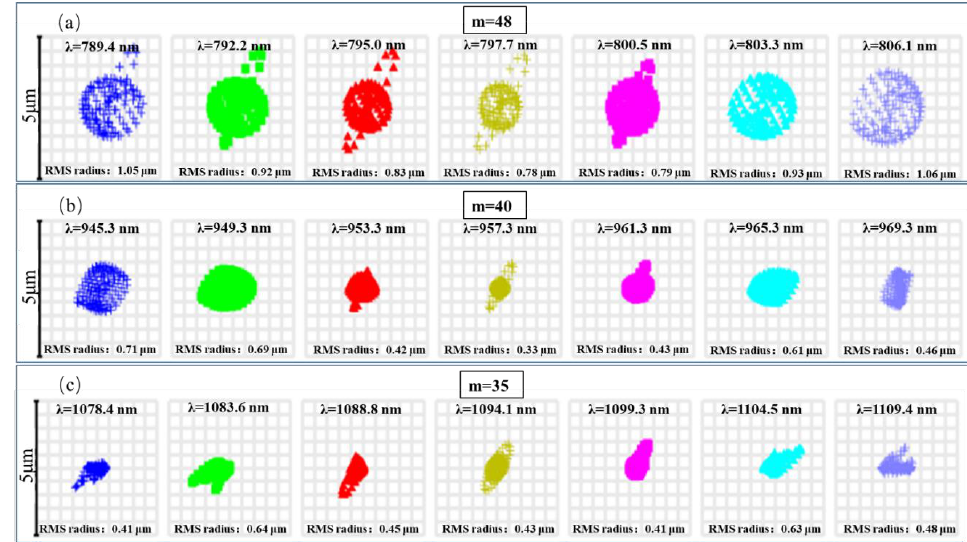
Figure 6. Spot diagrams of seven equally spaced wavelengths: ( a ) m = 48; ( b ) m = 40; ( c ) m = 35.